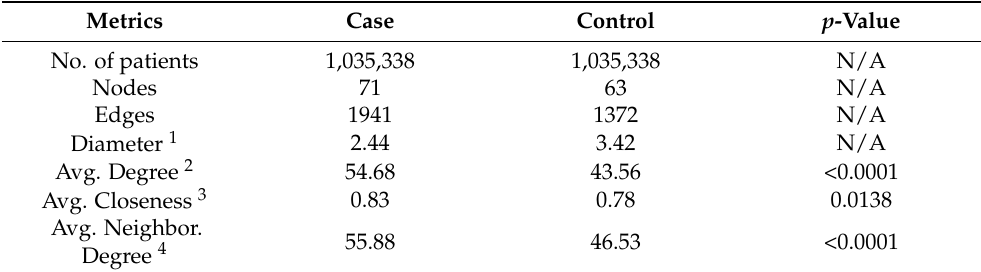
Table 2. Metrics of PDNs in IHD patients and controls.